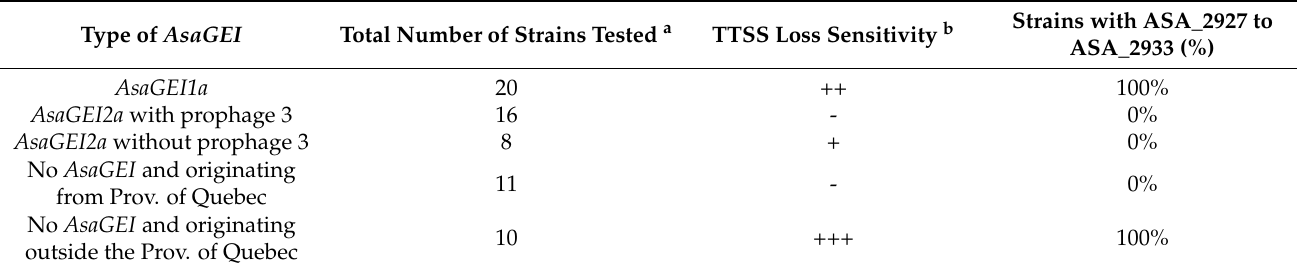
a : The numbers indicated represent the sum of Table 1 and Table S3. b : +++: 100% of the strains tested gave TTSS loss; ++: 50 to 99% of the strains tested gave TTSS loss; +: 1 to 49% of the strains tested gave TTSS loss; -: 0% of the strains tested gave TTSS